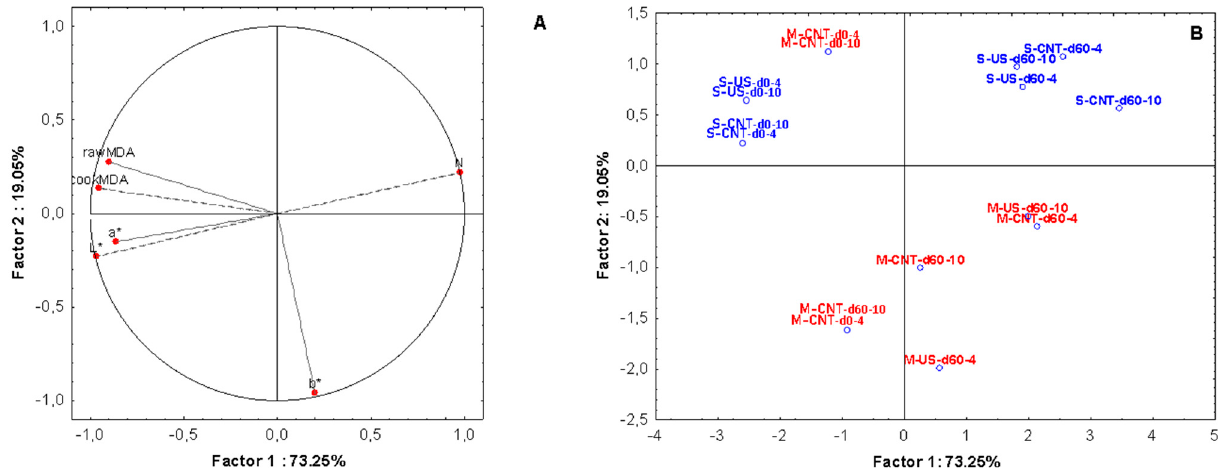
Figure 7. Principal component analyses (PCA) of pork meat brined with/without ultrasound and with NaCl or NaCl/KCl based on physicochemical data; ( A ) factor loadings and ( B ) projection of the four groups of treatments in the plane. Salt type: S (normal sodium content, blue colour), M (reduced sodium content, red colour); processing: CNT (Control), US (ultrasound); Day of storage: d0, d60; Temperature of storage: 4 °C, 10 °C.